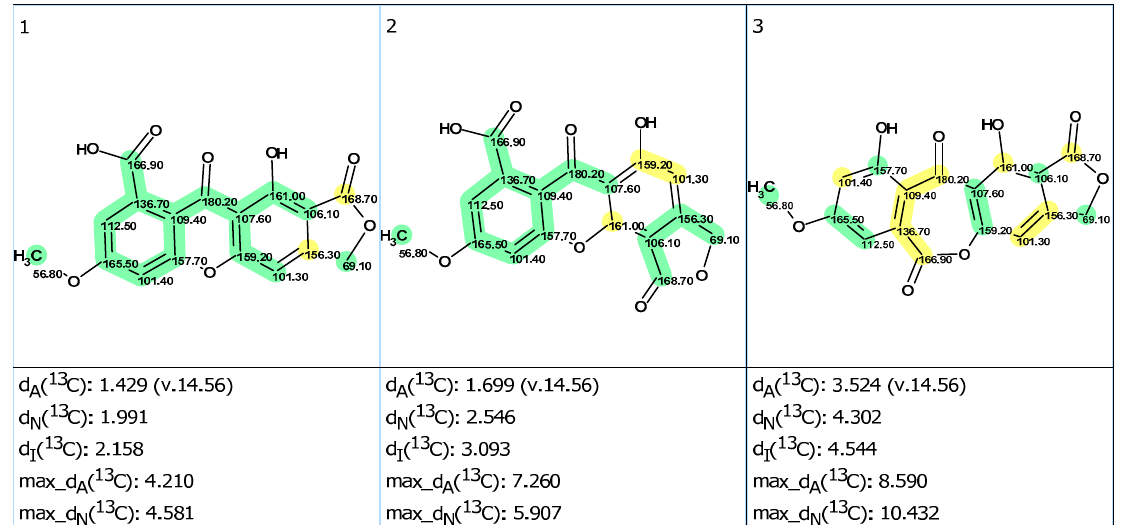
Figure 6. Three top-ranked candidate structures (1, 2 and 3) with 13 C chemical shifts measured in DMSO- d 6 . Designations of deviations are the same as for Figure 5. The color code refers to the accuracy of the 13 C NMR chemical shift prediction as follows: green = difference between theoretical and experimental < 3 ppm, yellow = difference comprised between 3 and 15 ppm, and red = difference over 15 ppm. Table 1. 1 H and 13 C NMR (700/175 MHz) Spectroscopic Data for 1